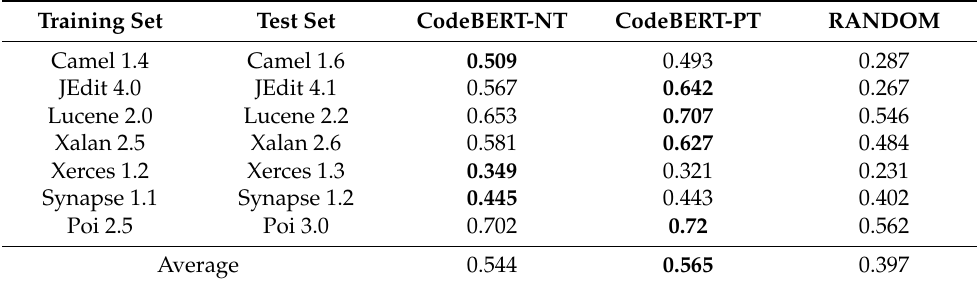
Table 3. Performance comparison of CodeBERT-NT, CodeBERT-PT, and RANDOM models on the CVPSC dataset for cross-version defect prediction. The float values are the average F-measure values. The best F-measure values are highlighted in bold.